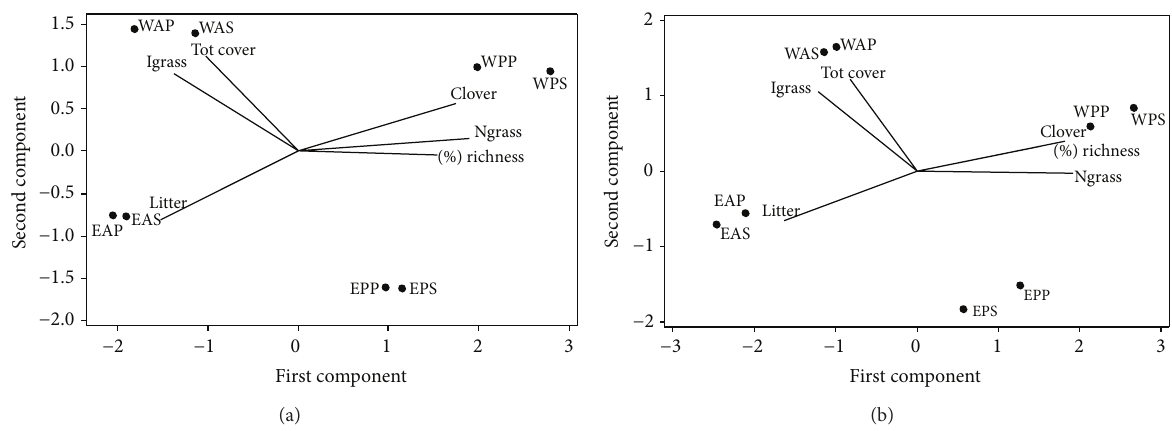
Figure 3: Examples of plots from exploratory principal components analyses of pitfall and sweep-netting morphospecies richness in (a) February 2007 and (b) the three surveys in 2007. Richness (% richness) is the number of morphospecies, for a particular method and sampling area, as a percentage of total morphospecies for that method over all sampling areas. For each sampling area (EP, EA, etc.) percentage richness for pitfalls (P) and sweep-netting (S) is shown. Other variables are the covers of native grass (Ngrass), clovers, total plant cover (Tot cover), introduced grass (Igrass), and the cover of plant litter on the surface.